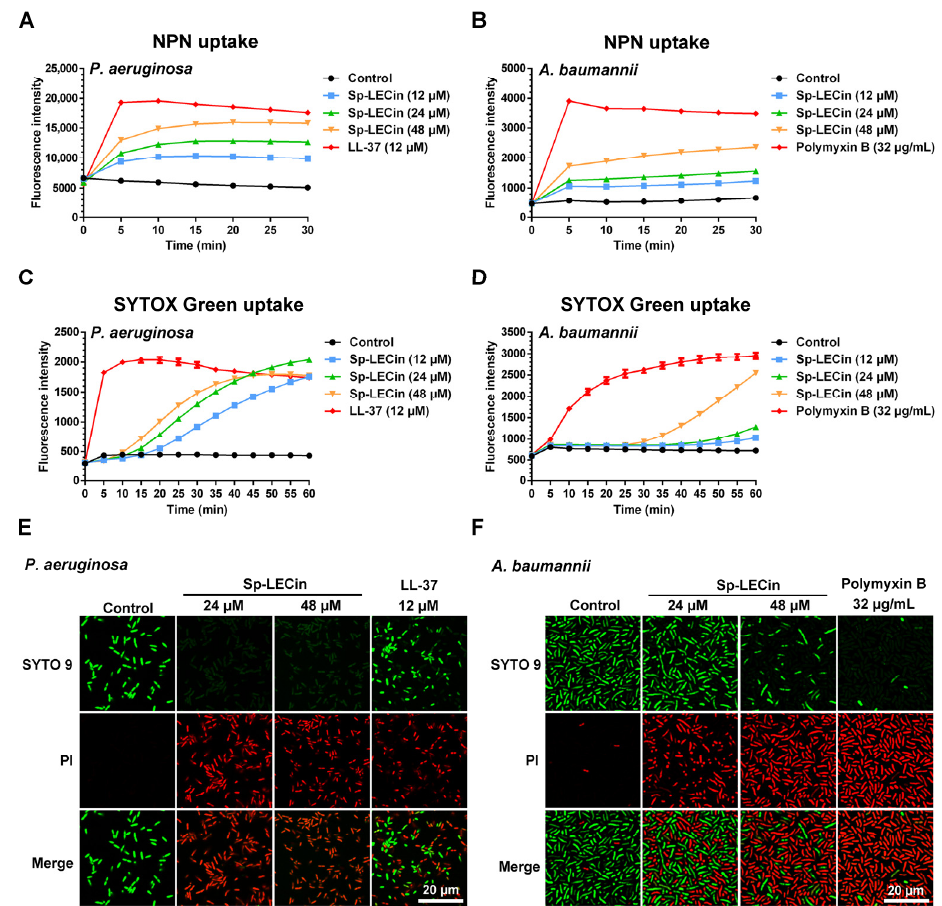
Figure 3. Effect of Sp-LECin on the membrane permeability of P. aeruginosa and A. baumannii . ( A , B ) Outer membrane permeability after Sp-LECin treatment was measured by N-phenyl-1-naphthylamine (NPN) uptake assay. The NPN fluorescence was recorded at the excitation and emission wavelengths of 350 and 420 nm, respectively. ( C , D ) Inner membrane permeability after Sp-LECin treatment was measured by SYTOX Green uptake assay. The SYTOX Green fluorescence was recorded at the excitation and emission wavelengths of 485 and 530 nm, respectively. The bars indicate the mean ± standard error of mean ( n = 3). ( E , F ) Confocal laser-scanning microscope (CLSM) images representing the cell membrane permeability by SYTO 9 and propidium iodide (PI) staining in P. aeruginosa and A. baumannii cells treated with Sp-LECin.